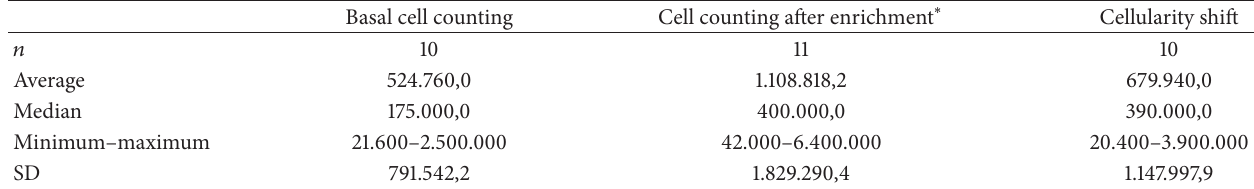
Table 2: Basal and after-enrichment cell counting in the